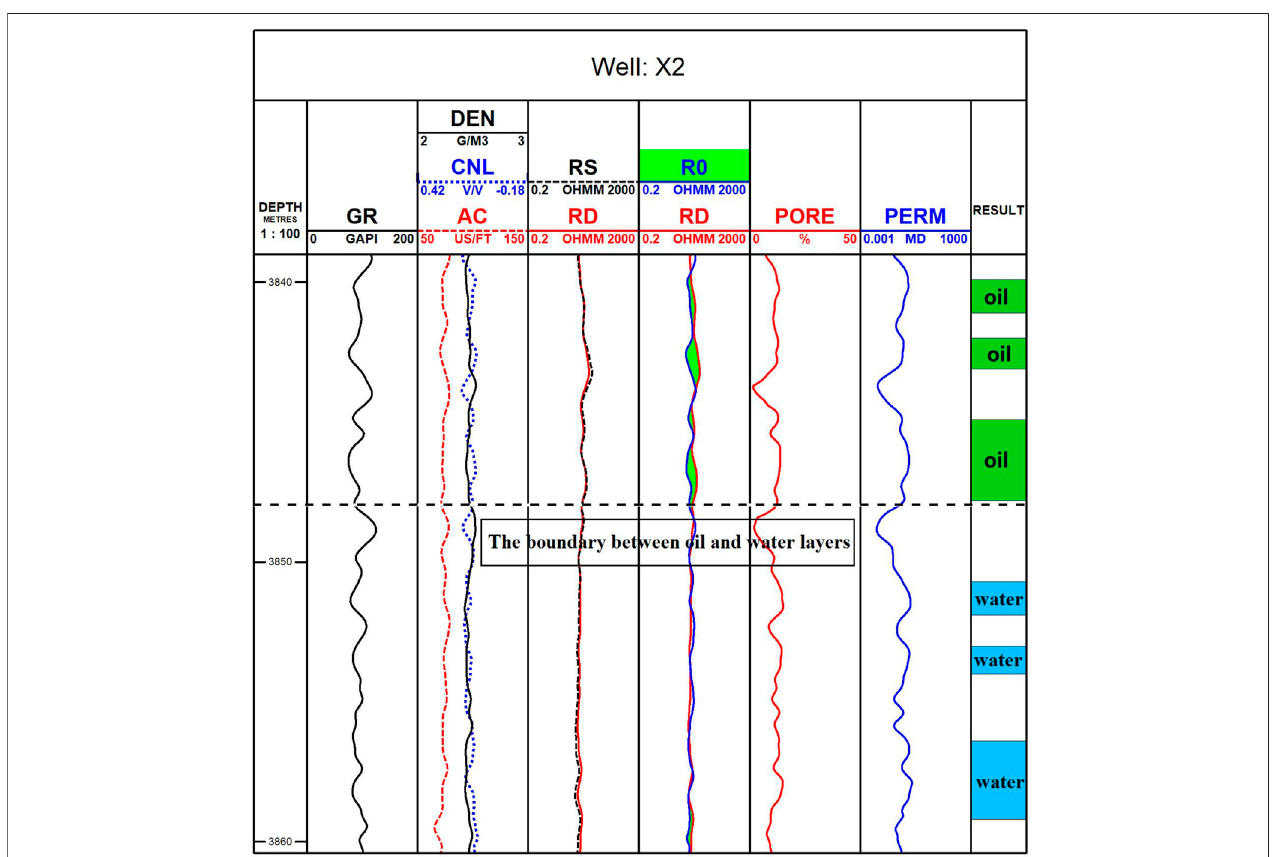
FIGURE 4 | Result plots of resistivity R 0 of saturated pure water predicted by the arti fi cial neural network.